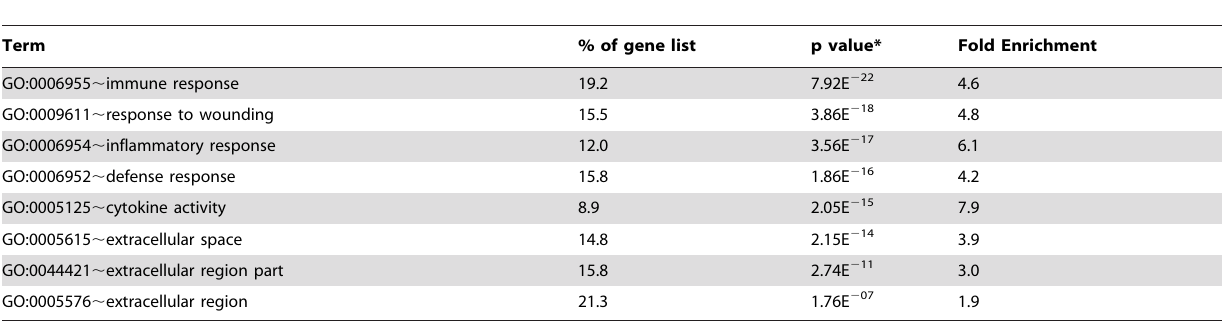
Table 1. Ontological associations of gene expression differences between AM and MDM.